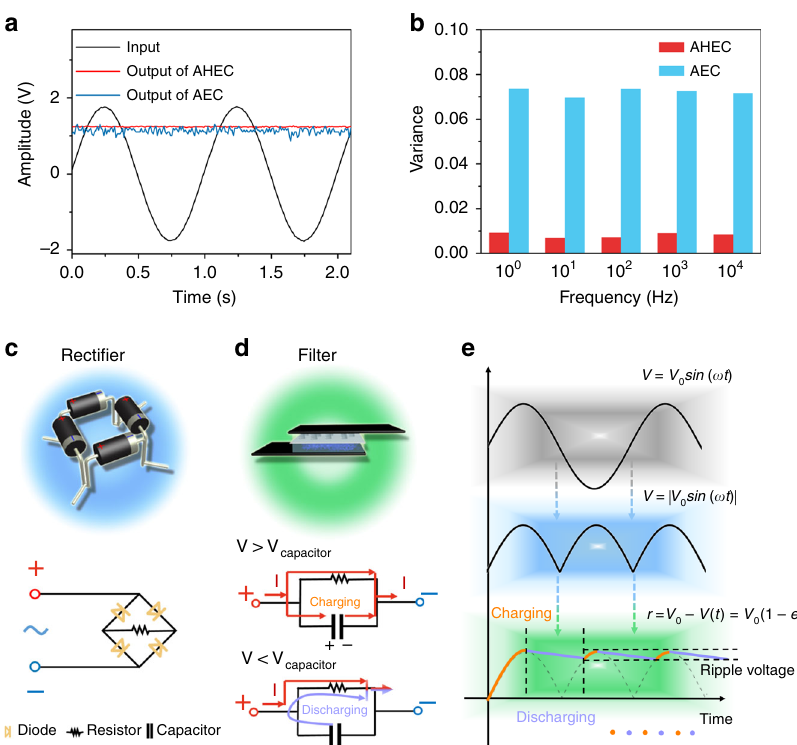
Fig. 5 The frequency fi ltering performances and fi ltering process. a AC line- fi ltering performance of the aqueous hybrid electrochemical capacitor (AHEC) unit and aluminum electrolytic capacitors (AEC) at 1 Hz. b Histogram of variance of the output signals data of AHEC and AEC vs. frequency. c The schematic illustration of recti fi er and its circuit. d The schematic illustration of AHEC unit and its fi ltering procedure. e The conversion process of the sinusoidal AC signal to DC signal. Source data are provided as a Source Data fi